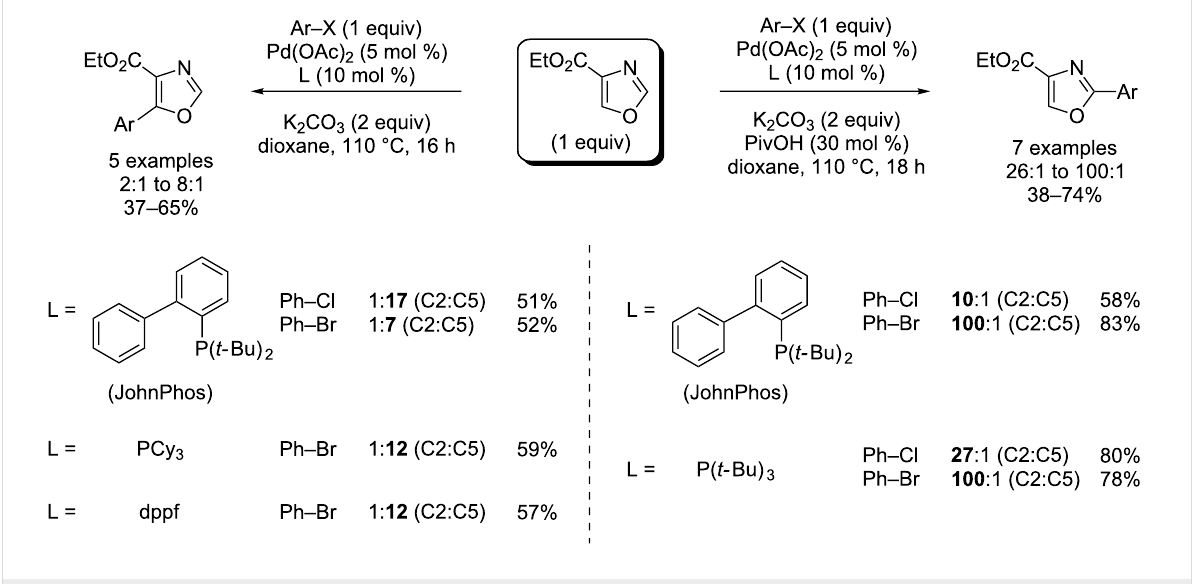
Scheme 16: Pd(0)-catalyzed C2- and C5-selective (hetero)arylation of ethyl oxazole-4-carboxylate